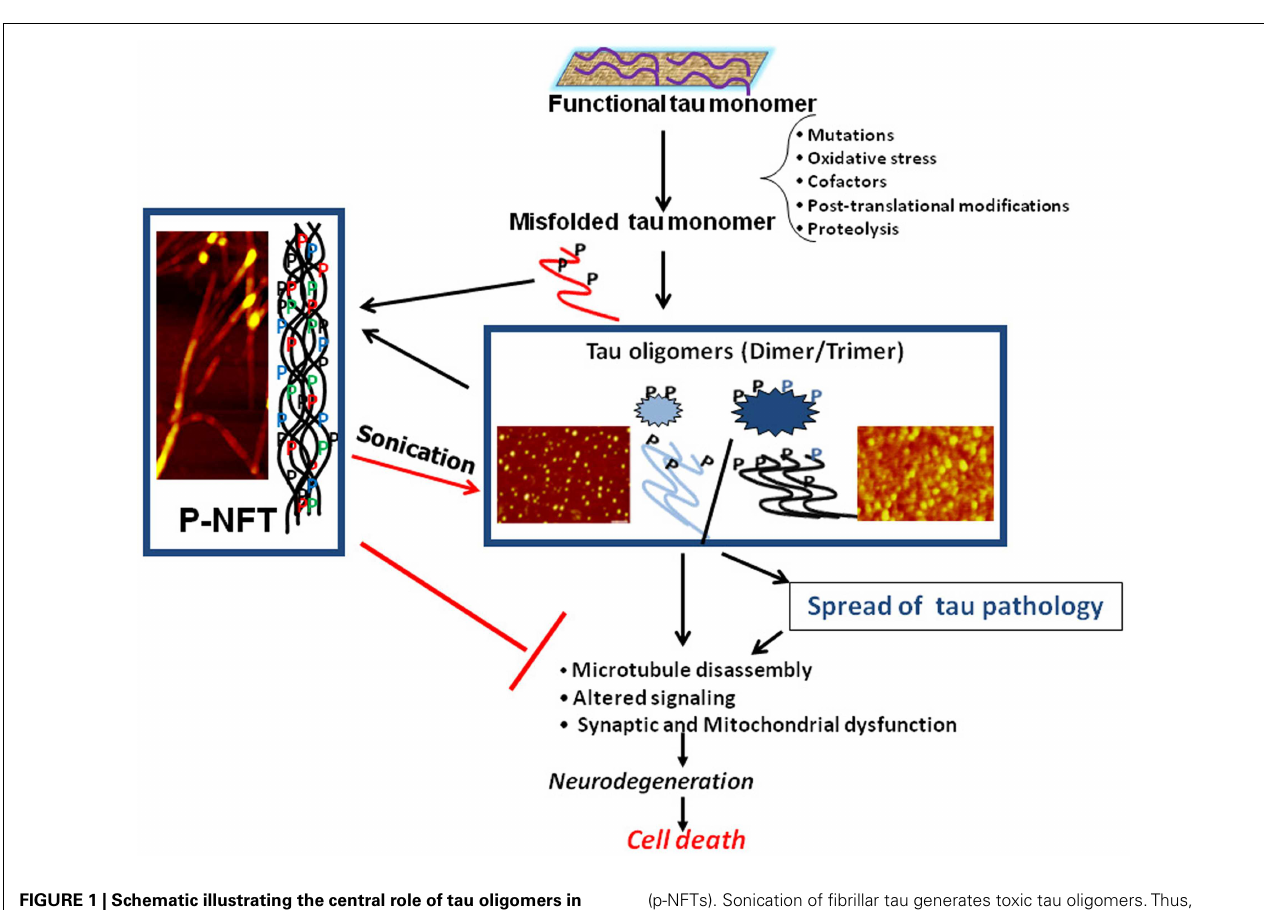
FIGURE 1 | Schematic illustrating the central role of tau oligomers in tauopathies .Tau intermediate soluble aggregates (tau oligomers) are the toxic tau entities and initiators of tau pathology and propagation in tauopathies, rather than monomeric tau or hyperphosphorylated NFTs